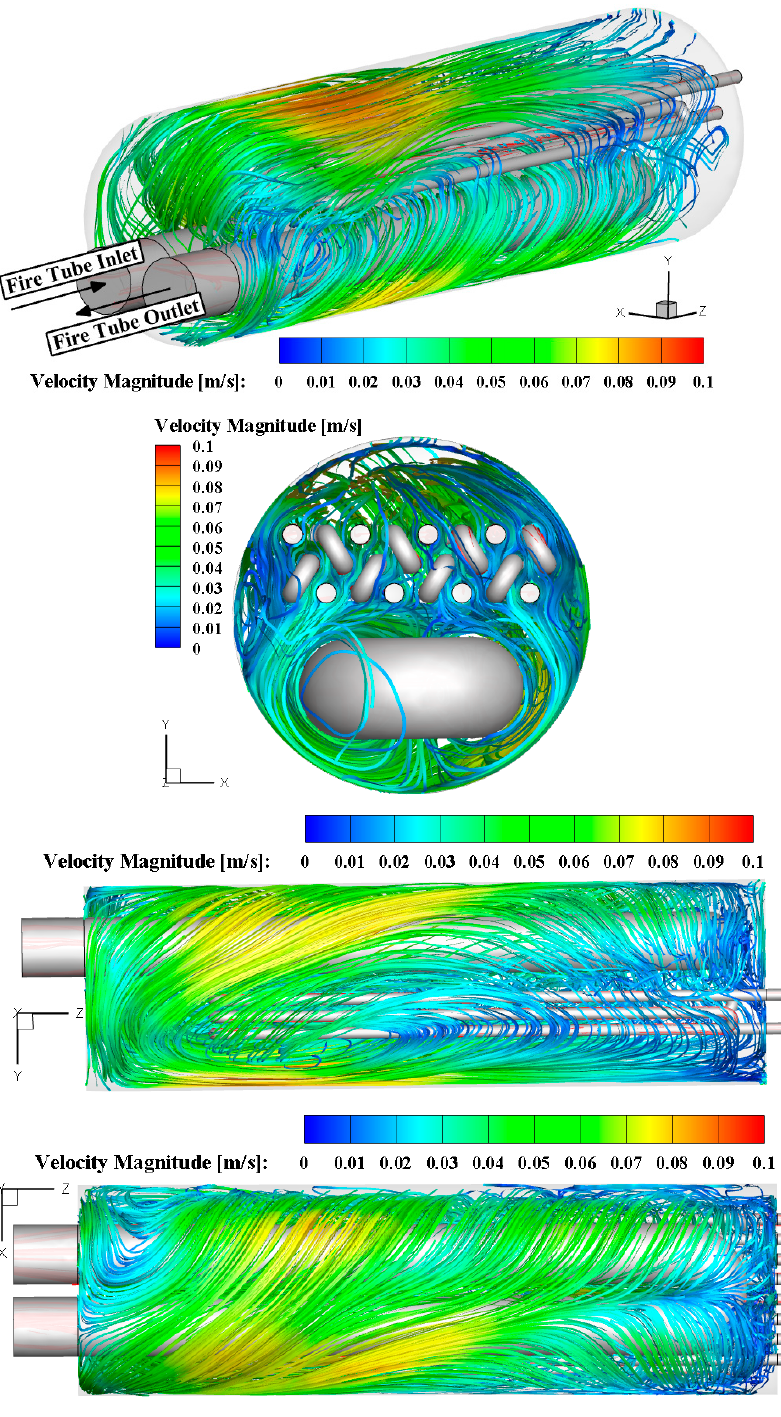
Figure 16. The streamline with the contour of velocity magnitude inside the water tank of the heater under study.